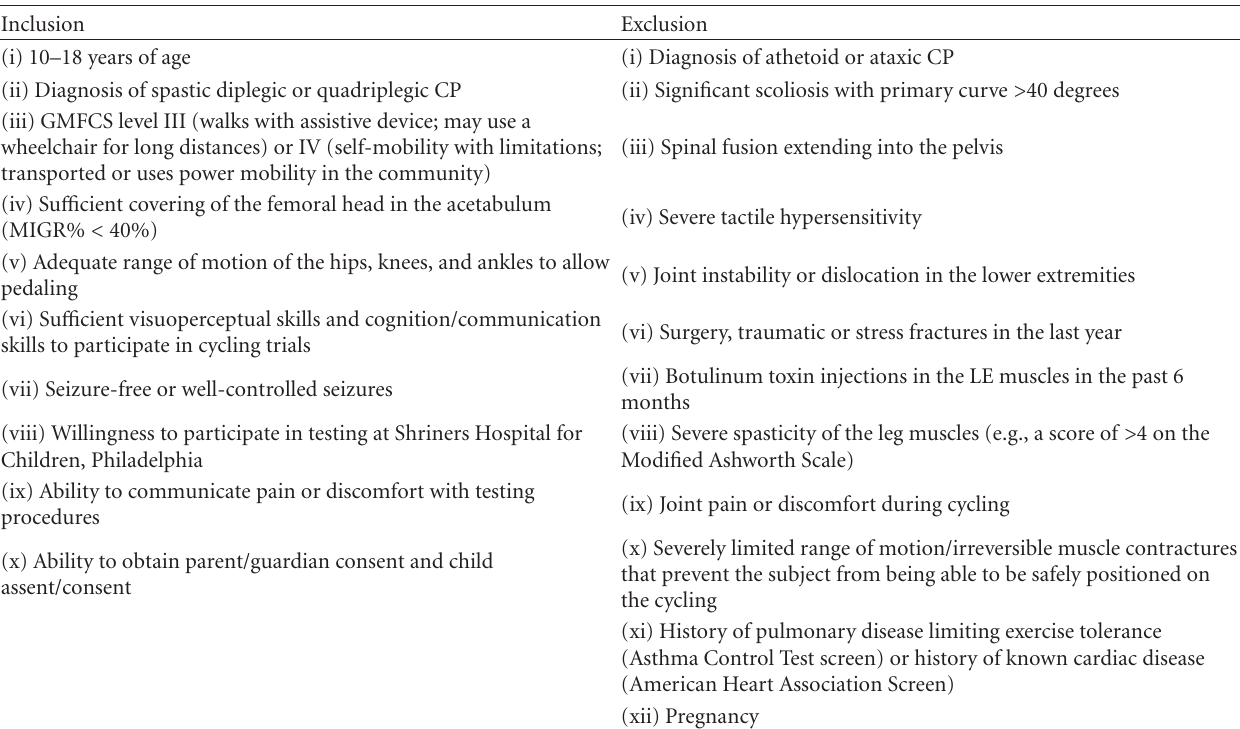
Table 1: Inclusion and exclusion criteria for participation.